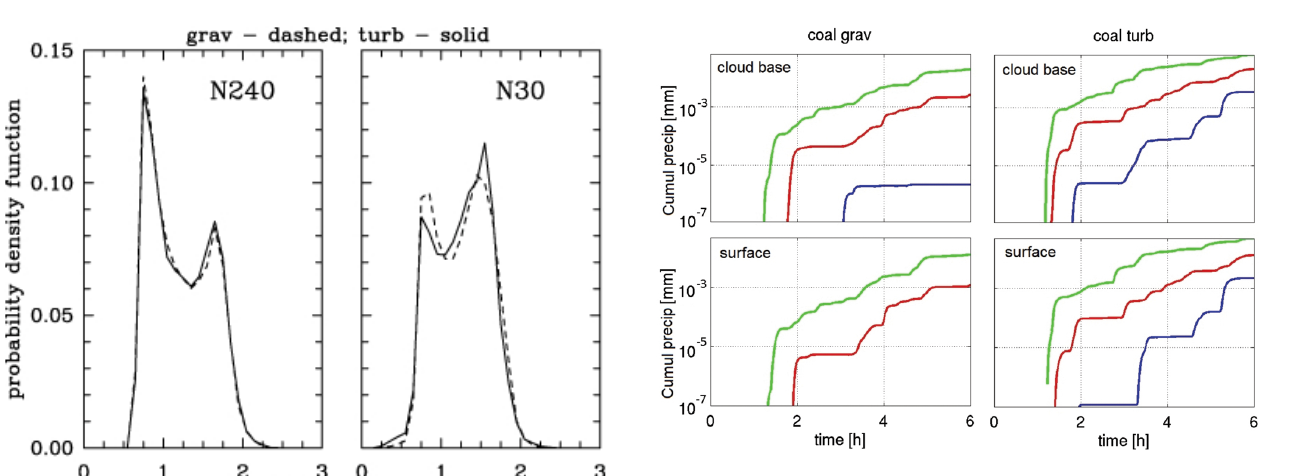
Fig. 15. Same as Fig. 14 but with the logarithmic scale on the verti- cal